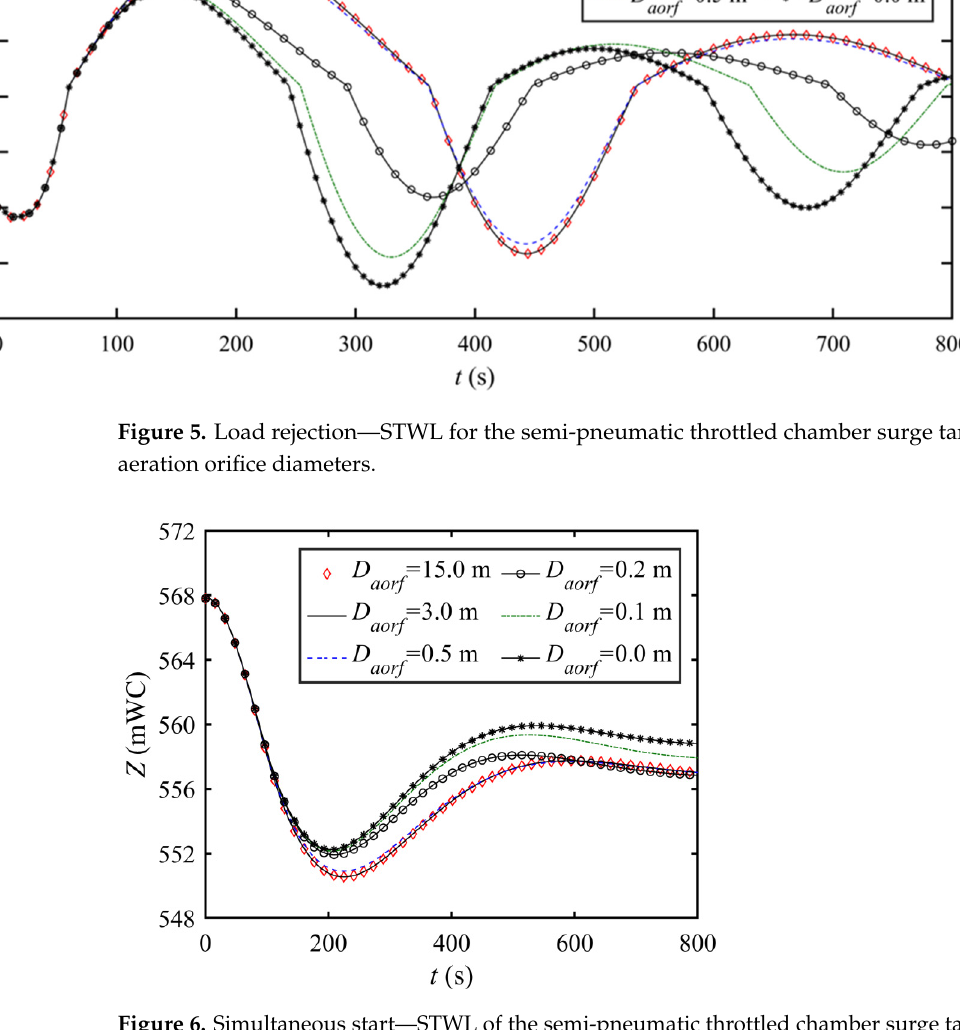
Figure 6. Simultaneous start—STWL of the semi-pneumatic throttled chamber surge tank for various aeration orifice diameters.